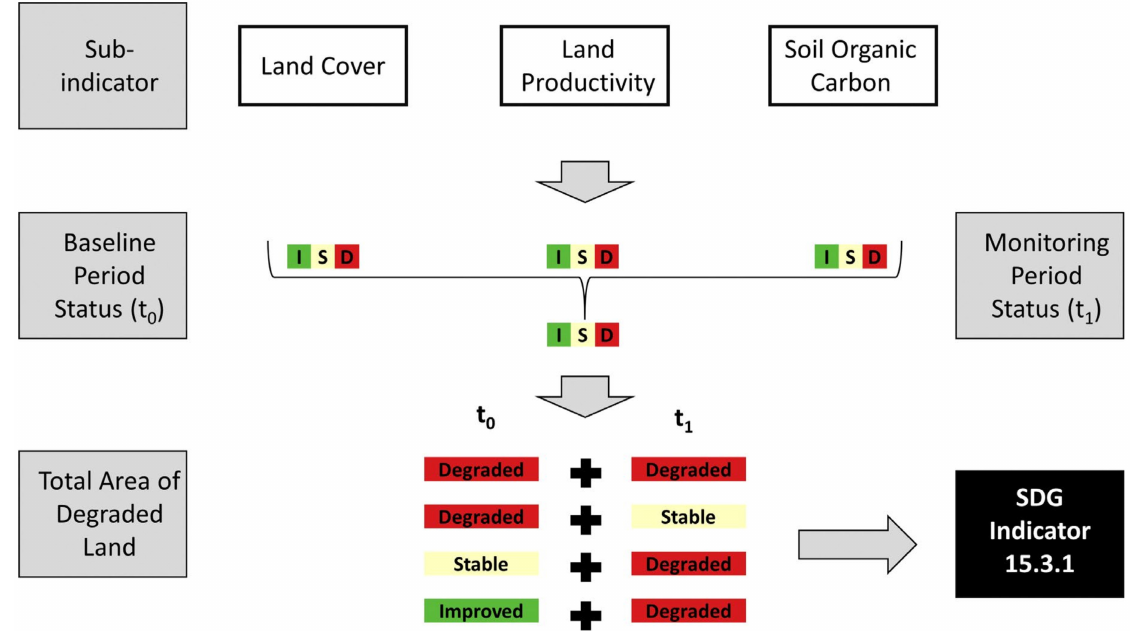
Figure 2. Steps to derive the sustainable development goal (SDG) indicator 15.3.1 from the sub-indicators. I represents Improvement, S represents Stable and D represents degraded (based on